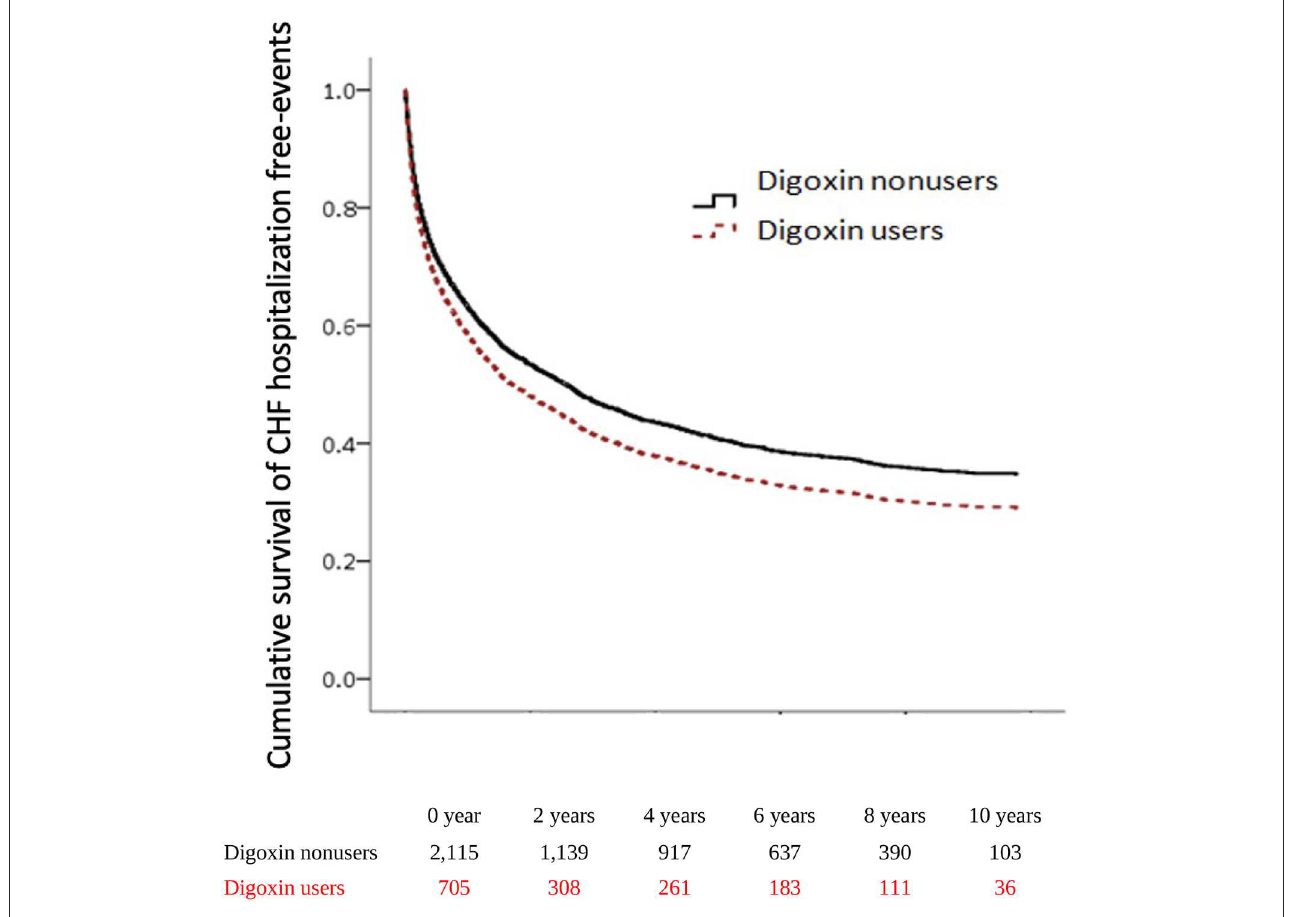
FIGURE3 Cumulative hazards of CHF hospitalization among patients with